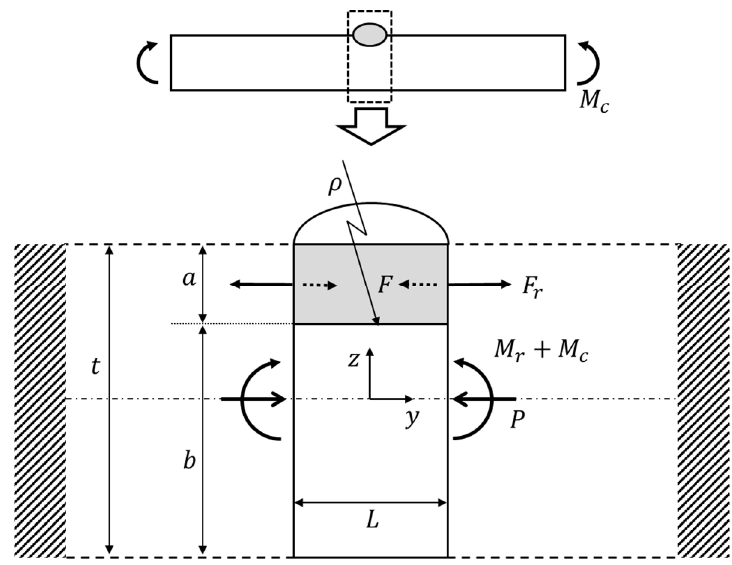
Figure 1. Free body diagram of welding distortion ( t : plate thickness, a: height of plasticity area, L : width of plasticity area, ρ : curvature, F : force by weld shrinkage, F r : reaction force, M r : reaction moment of base plate, M c : reaction moment by surrounding structures, including external moment).